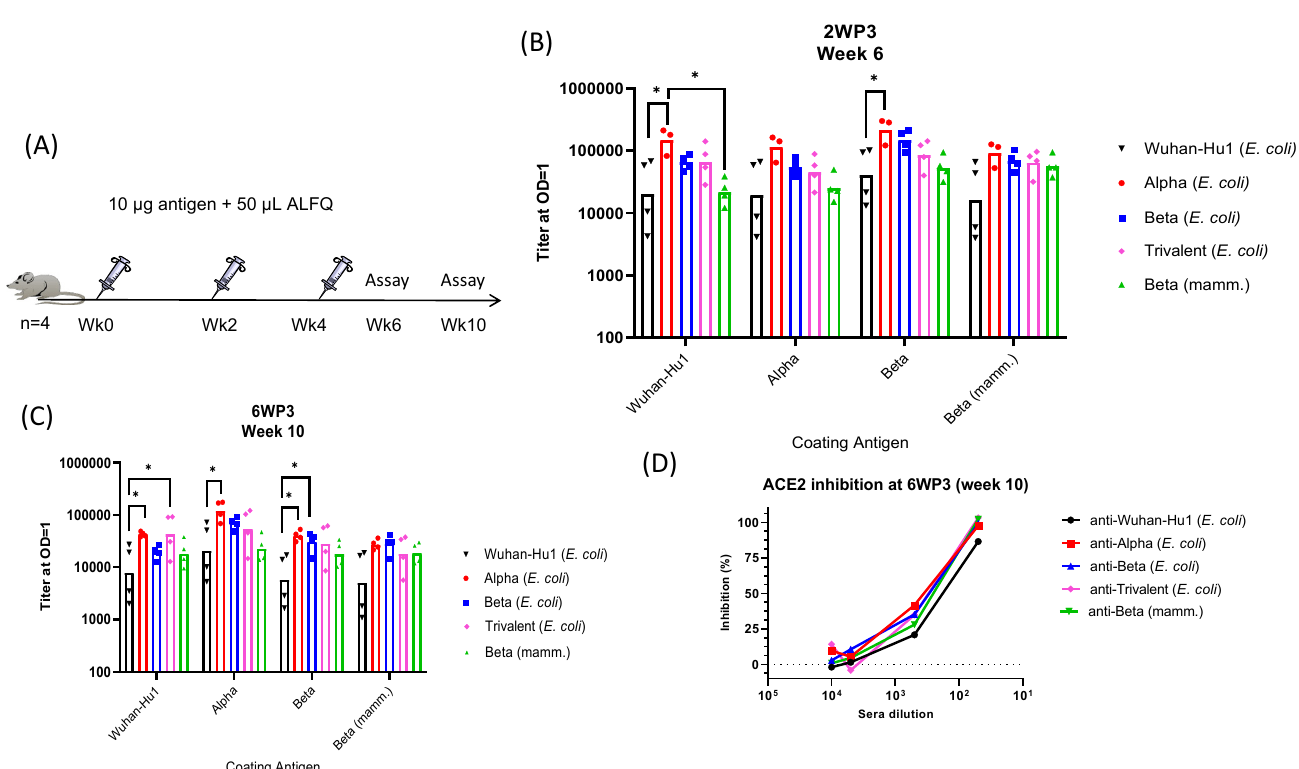
Figure 4. Immunogenicity of recombinant RBDs. ( A ) Schematic of the mouse study design. ( B ) ELISA (OD = 1 titer) against Wuhan-Hu1, Alpha, and Beta coat antigens at 2WP3 (week 6) and at ( C ) 6WP3 (week 10) are shown. Individual mouse titers are indicated for each vaccine group ( E. coli Wuhan-Hu1, black inverted triangles; E. coli Alpha, red circles; E. coli Beta, blue squares; trivalent, pink diamonds; mammalian Beta, green triangles), while geometric mean titers are indicated by each bar. ( D ) Inhibition of homologous RBD binding to human ACE2 by serum pool collected at week 10 (6WP3). Inhibitions are relative to inhibition by normal mouse serum at a 1:50 dilution (adjusted to 0%; not plotted). Significant p -values between groups are shown with * ( p < 0.05).